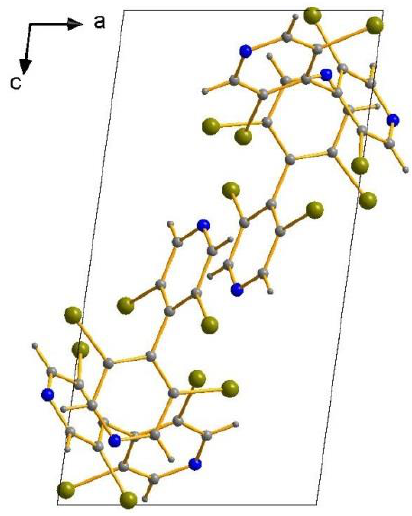
Figure 2. Crystal packing in the structure of 1 . Here and below: C and H grey, N deep blue, Br ol- ive - green.